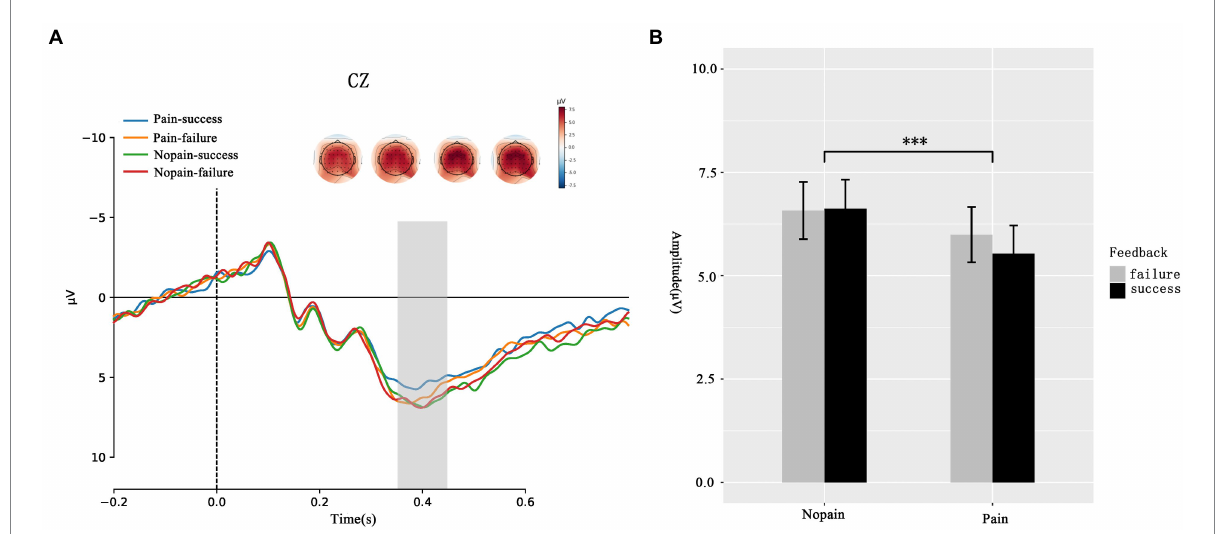
FIGURE 3 P300 during the feedback screen. (A) Average ERP waveforms and scalp topographies for pain (pain vs. nopain) and feedback (success vs. failure) during the task. Displayed waveforms were measured at CZ. Amplitudes of dominant component P300 elicited by the feedback were compared. (B) Histogram for the P300 in the pain and nopain conditions. *** p <